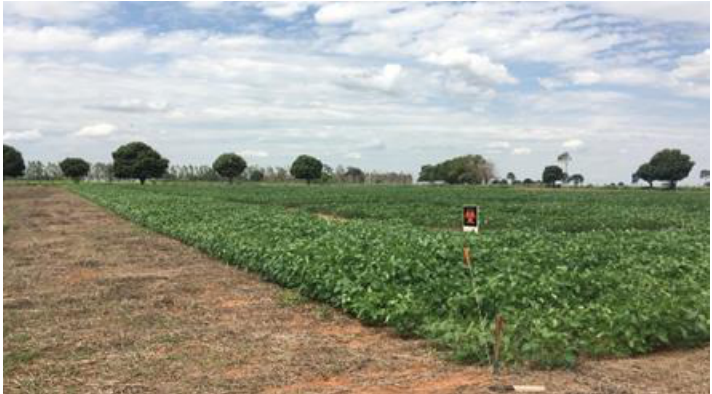
Figure 3. The experimental area at Unoeste University.